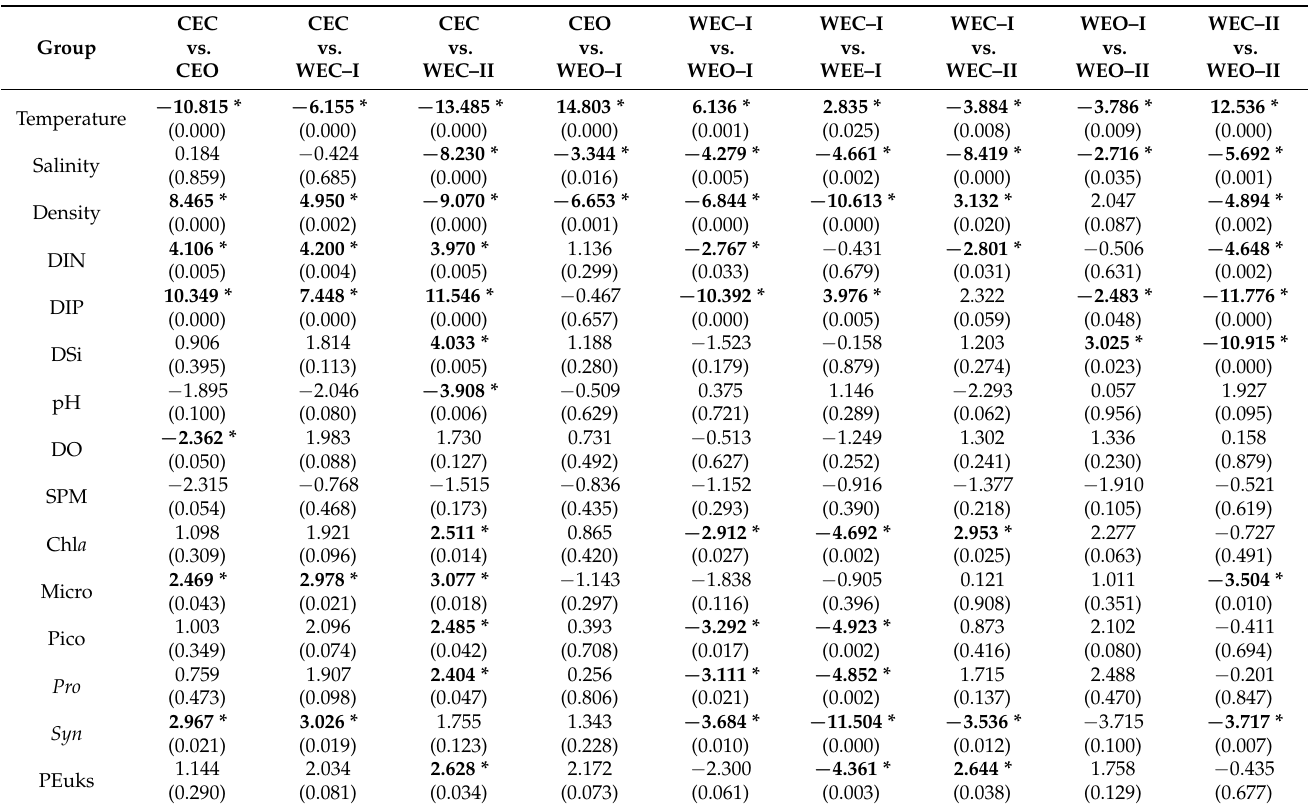
Table 1. Paired t test of biogeochemical variables between cold and warm